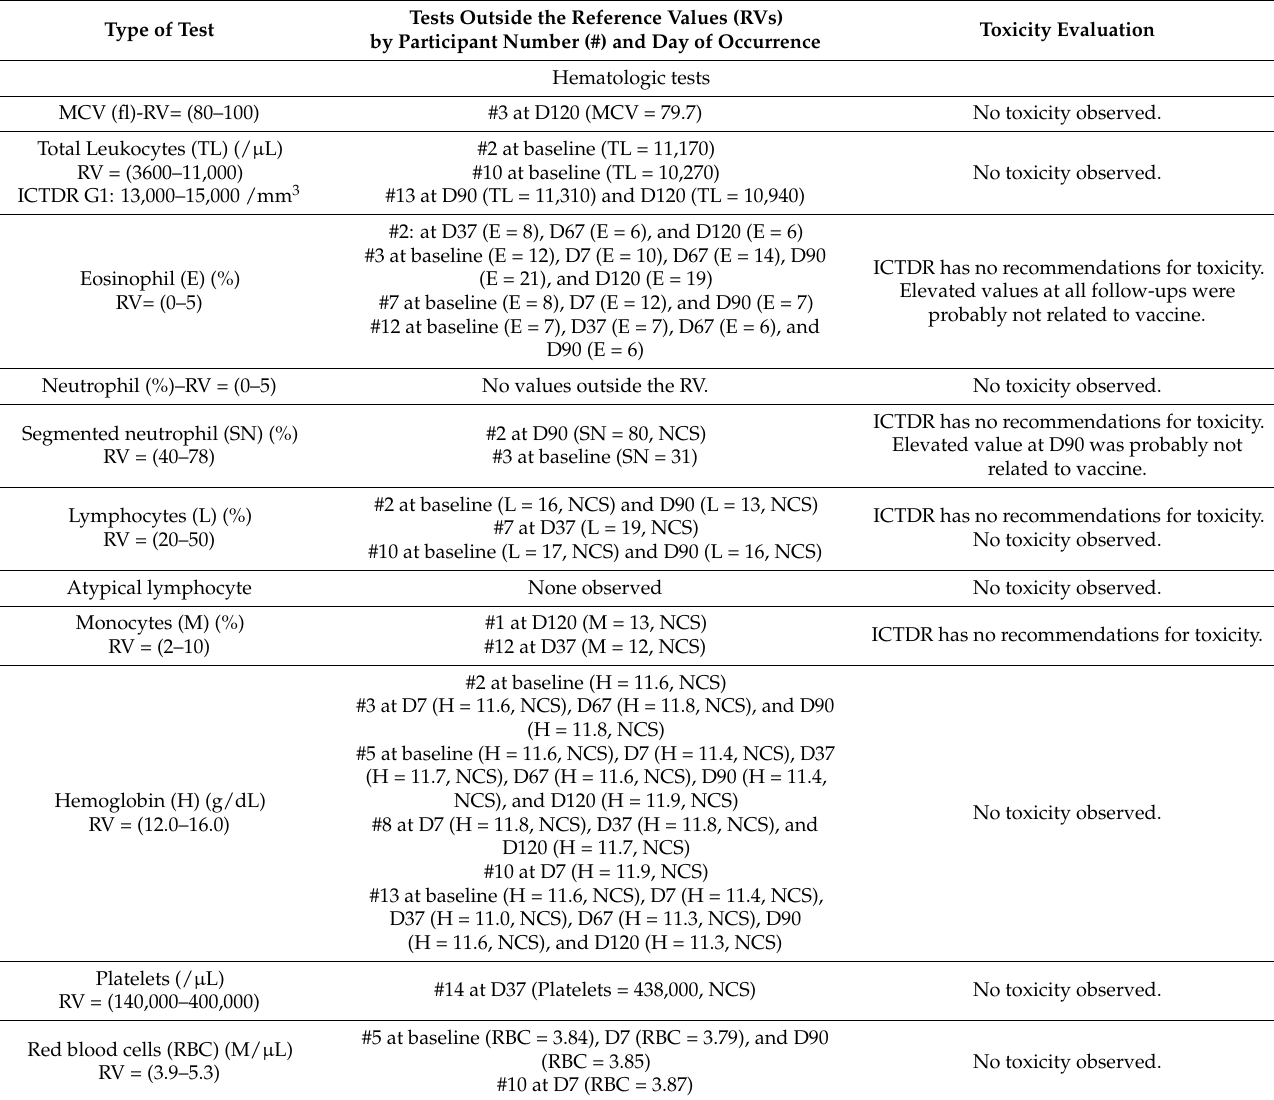
Table 4. Summary of laboratory tests and physical exams in ten Sm14-vaccinated